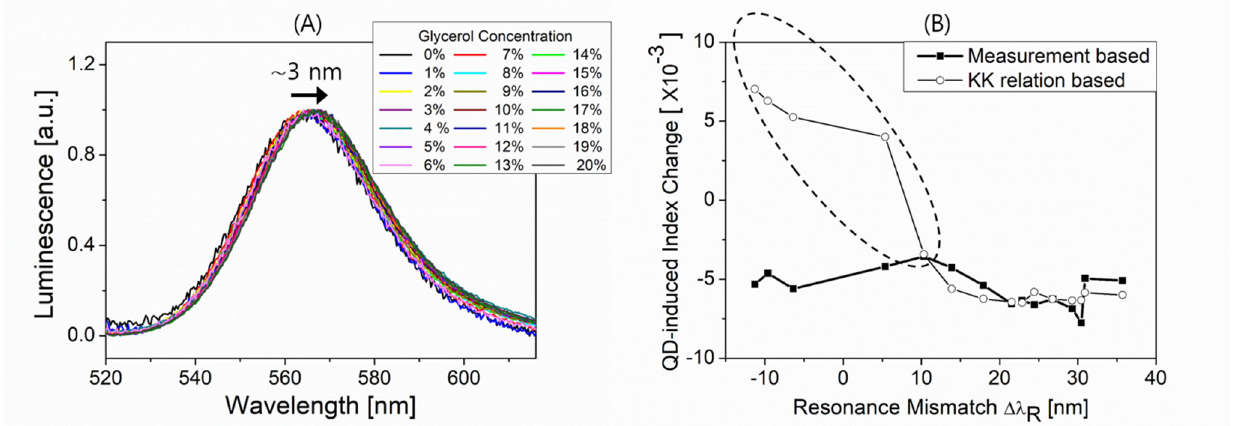
Figure 6. ( A ) Fluorescence of QDs immobilized on the bimetallic layer under excitation of 470 nm LED. The peak wavelength shifts from about 564 nm to 567 nm with varying surrounding glycerol concentrations from 0 to 20%. ( B ) QD-induced index change versus resonance mismatch ∆ λ R . Here ∆ λ = λ SPR − λ PL increases with glycerol R peak peak